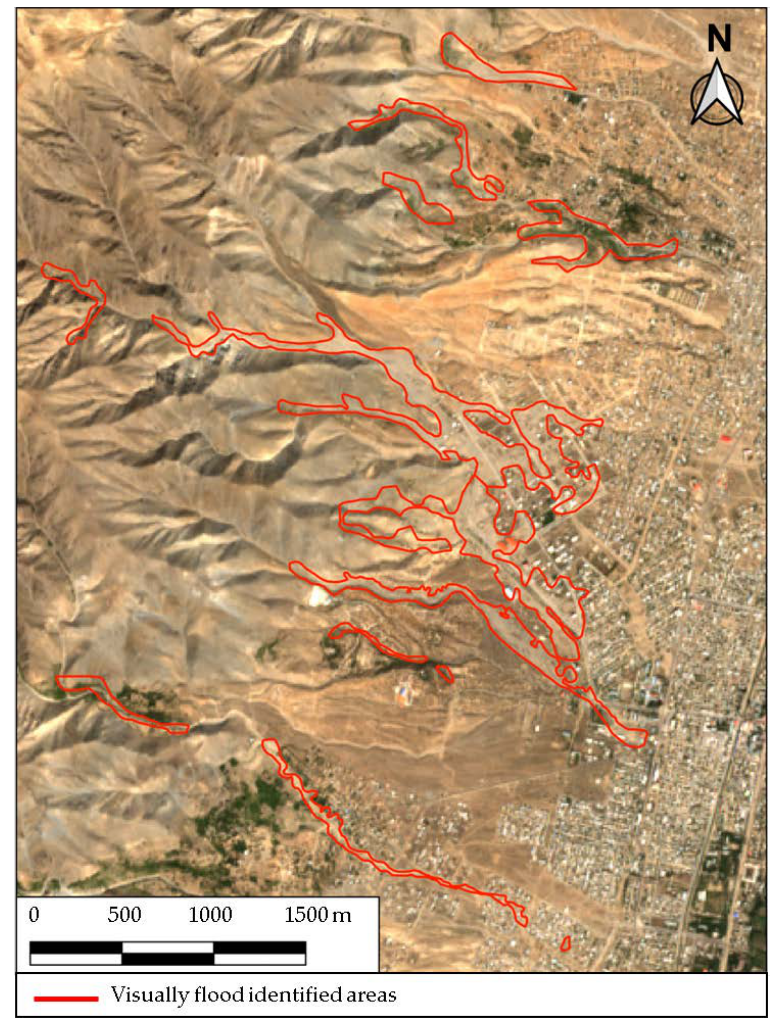
Figure 15. Visual interpretation of the flood-inundated area. Image drawn from our visual interpretation with government reports.